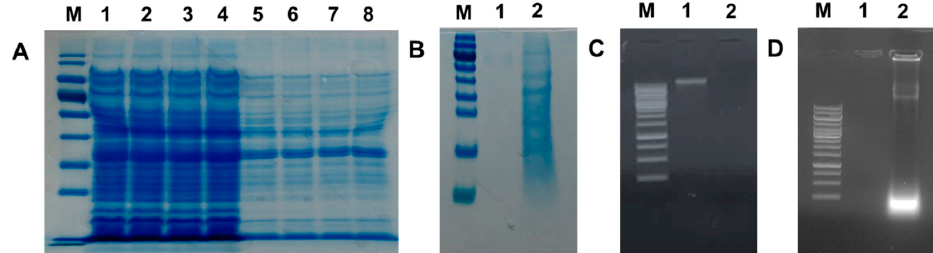
Figure 5. Characterization of culture pellets and supernatants of V. parahaemolyticus PCU-1 treated with MIC of NaOH. ( A ) Total proteins extracted from culture pellets of untreated bacterial cells (lanes 1–4: 15, 30, 45, and 60 min) and NaOH-treated VPGs (lanes 5–8: 15, 30, 45, and 60 min). M: Protein Marker; ( B ) Total proteins extracted from culture supernatants of untreated (lane 1) and NaOH-treated bacterial cells for 60 min (lane 2). Agarose gel (1%) electrophoresis of culture pellets containing VPGs ( C ); and culture supernatants ( D ). M: 1 kb Marker Ladder, lane 1: untreated V. parahaemolyticus PCU-1 (60 min) and lane 2: NaOH-treated V. parahaemolyticus PCU-1 (60 min).